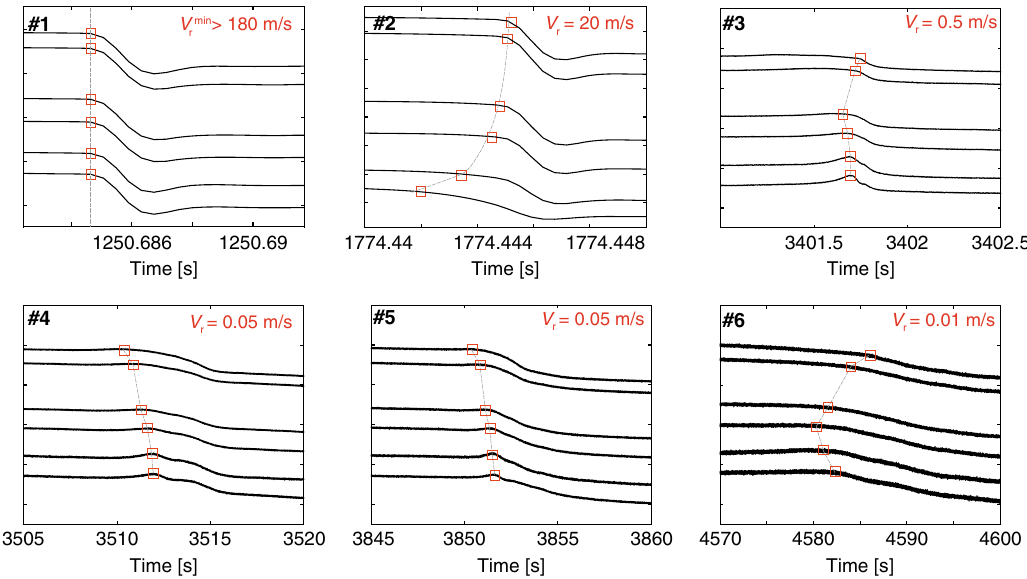
Fig. 4 Propagation of rupture along the interface during slip events. The rupture velocity is estimated using an equidistant strain gage array along the fault. The average rupture velocity is computed using the average travel time for the rupture front. The numbers displayed at the top left corner of each plots refer to the events presented in Fig. 3a, b.